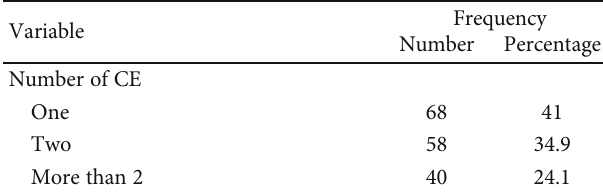
Table 1: Demographic features of participants in the